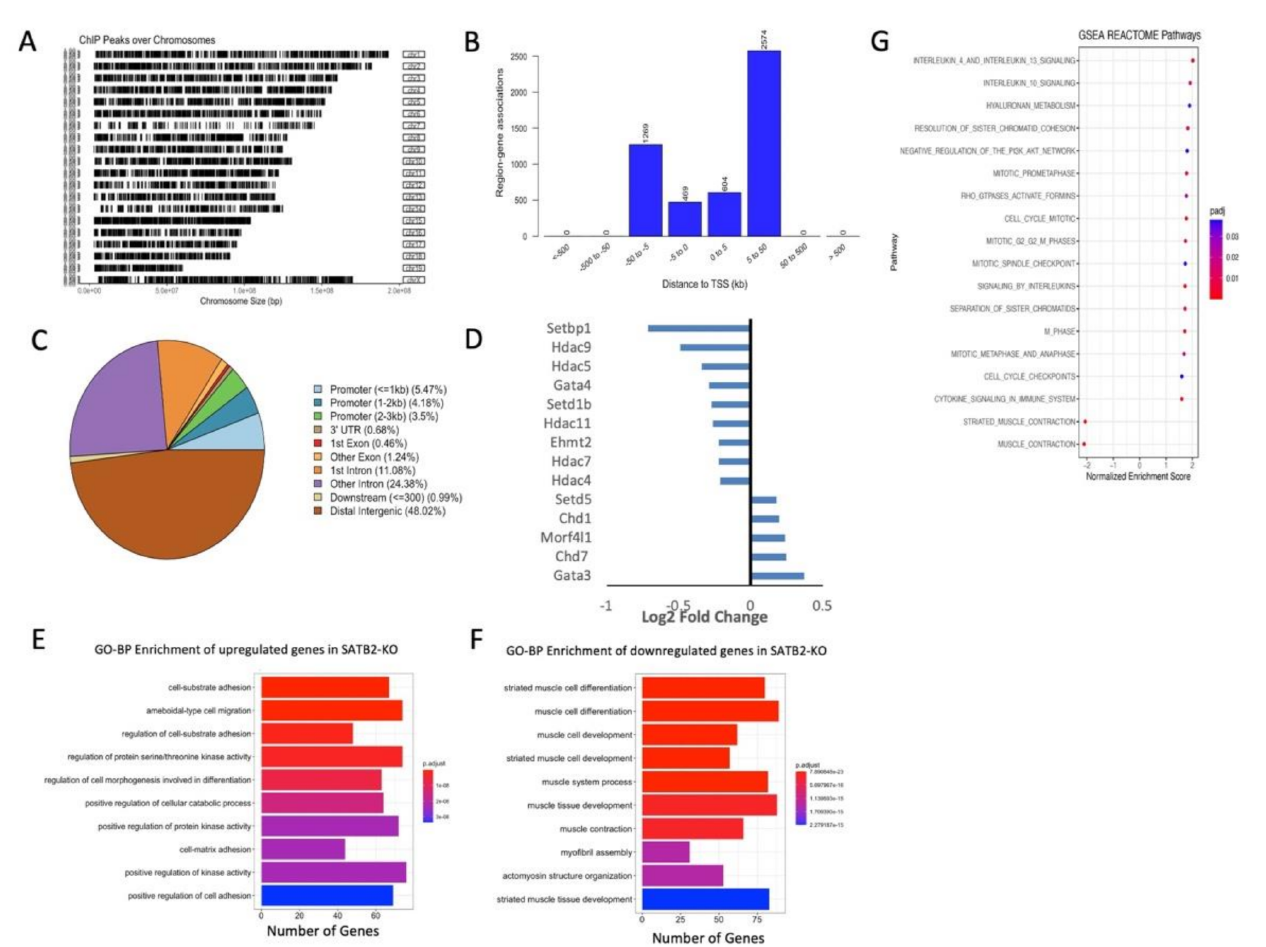
Figure 3. SATB2 regulates the expression of genes associated with chromatin remodeling and cell differentiation. ( A ) Chromosome distribution of SATB2 binding sites as determined from our ChIP- seq analyses (using ChIPseeker) on proliferating C2C12 cells. ( B ) Distribution of SATB2 binding sites within the muscle satellite cell genome with respect to the closest associated gene transcrip- tion start site (TSS). ( C ) Genomic context of SATB2 binding sites as determined by ChIPseeker. ( D ) Differentially expressed chromatin remodeling genes after inhibition of Satb2 expression in 24 h differentiated myoblasts, as determined using DESeq2 following our RNA-seq experiments. ( E ) Top GO biological process (BP) categorization of the genes upregulated following Satb2 repression in 24 h differentiated myoblasts. ( F ) Top GO-BP categorization of the downregulated genes following Satb2 siRNA-mediated repression in 24 h differentiated myoblasts. Analyses in ( E , F ) were provided by ClusterProfiler. ( G ) Gene Set Enrichment Analysis (GSEA) for differentially expressed genes identi- fied by RNA-seq. The Reactome bioinformatic tool was used for pathway analysis and identified a number of gene clusters known to promote myoblast